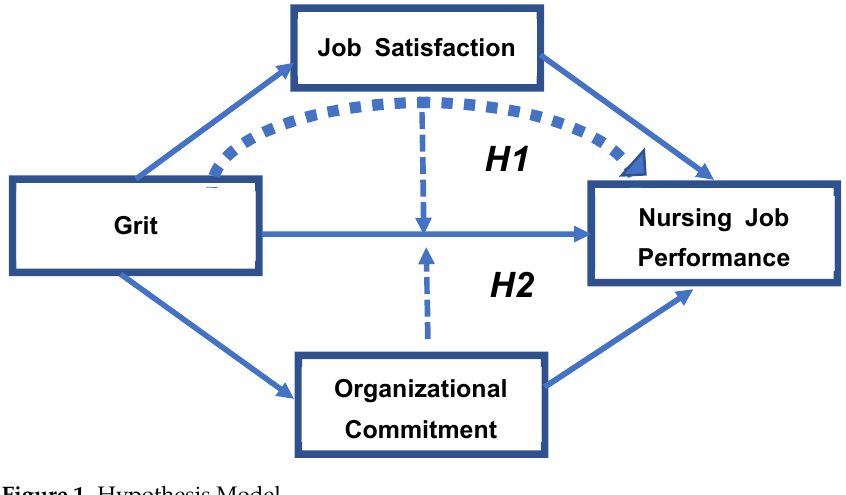
Figure 1. Hypothesis Model.